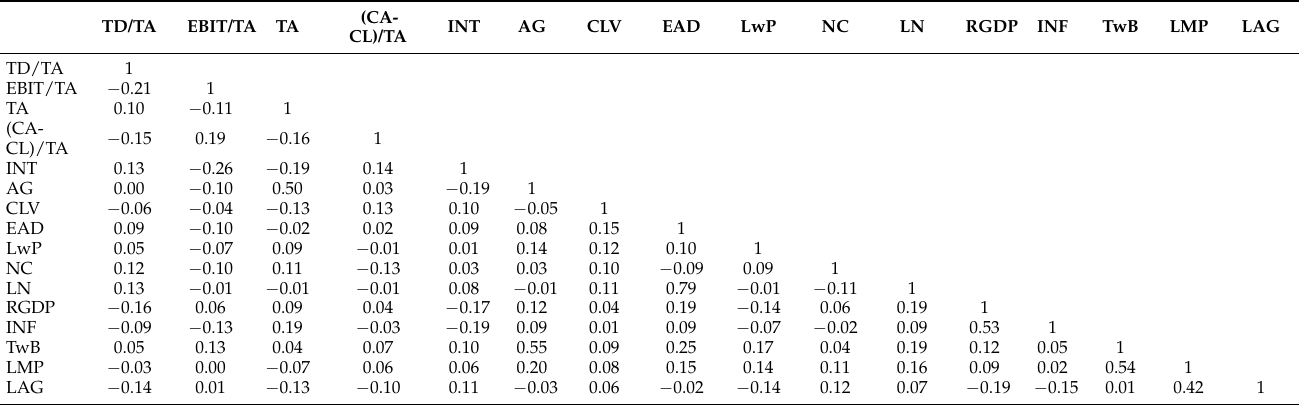
Table A2. Correlation coefficient matrix for recovery rate drivers incorporated into the